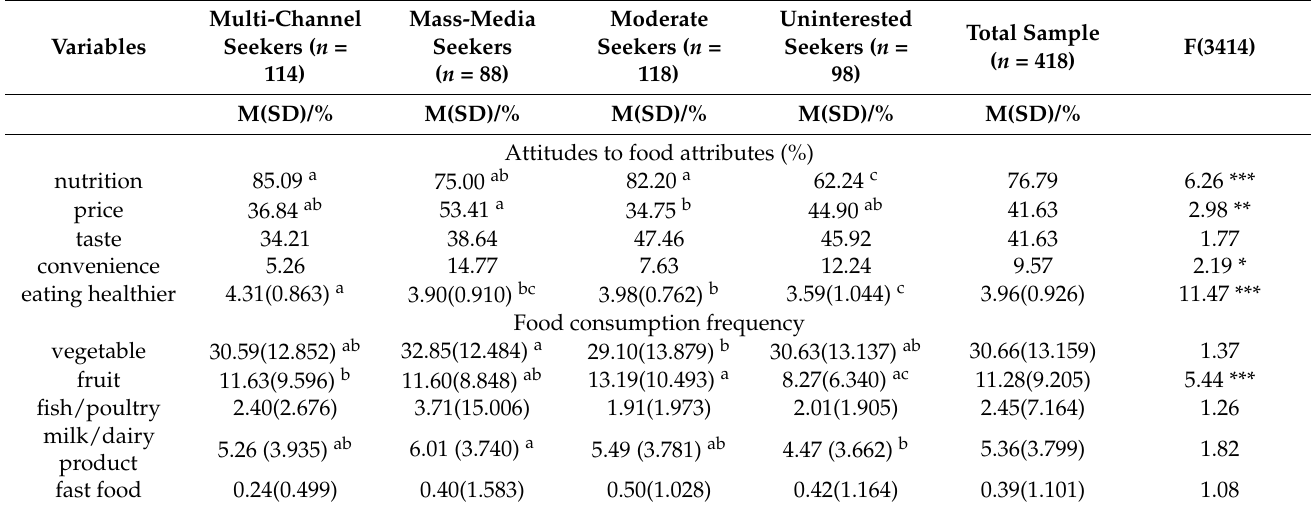
Table 4. Attitudes related to food attributes and food consumption of the four